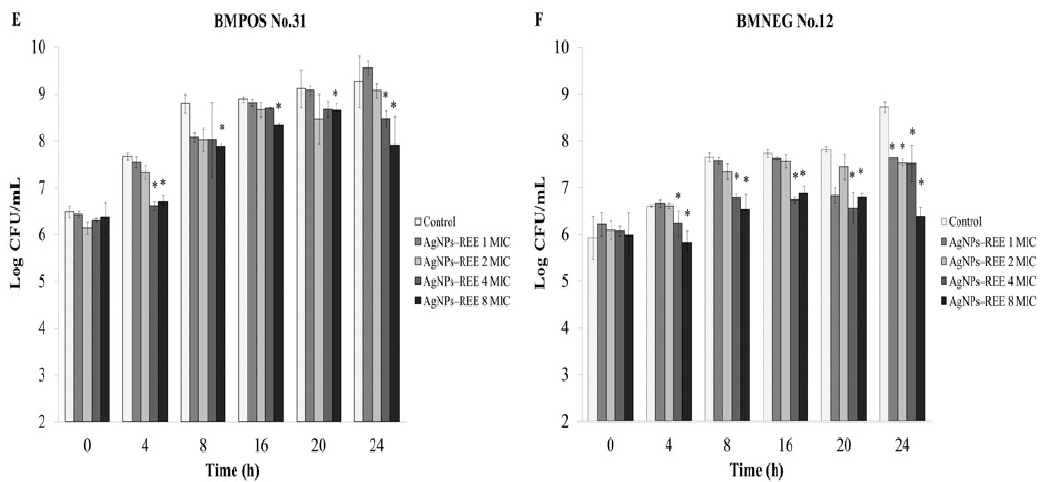
Figure 4. Quantification of bacterial invasion by ex vivo anti-infection assay. Each bar represents the number of invasive bacteria isolated from the bovine udder tissue as evaluated by the viable plate count. The bacterial transfected tissues were treated with 1 × minimum inhibitory concentration (MIC), 2 × MIC, 4 × MIC, and 8 × MIC of the ethanolic extract; R. tomentosa ethanolic extract (REE) ( A – C ) or synthesized AgNPs with capped REE (AgNPs-REE) from the ethanolic extract ( D – F ) at various time points (h). 1% DMSO was used as a control. The data represent the pooled results from two experiments and are expressed as a mean value ± standard deviation (SD). * p < 0.05, compared to the control.